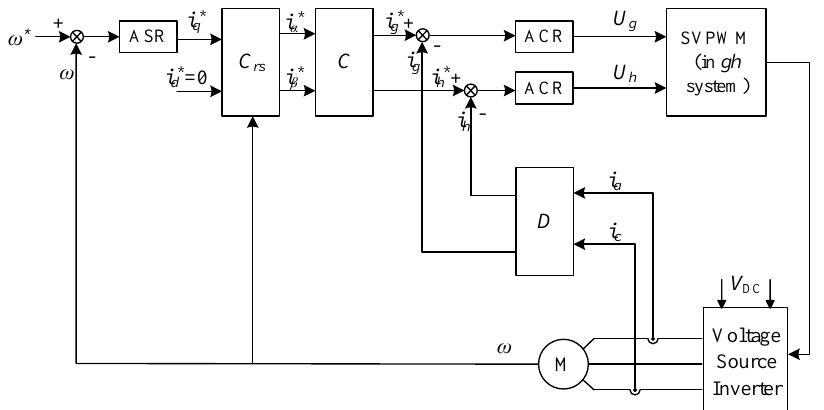
Figure 6. FOC structure of the PMSM in the 60° coordinate